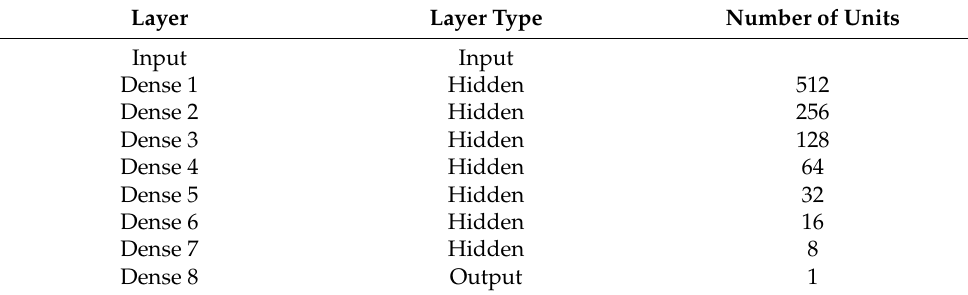
Table 3. The structure of the proposed DNN model.